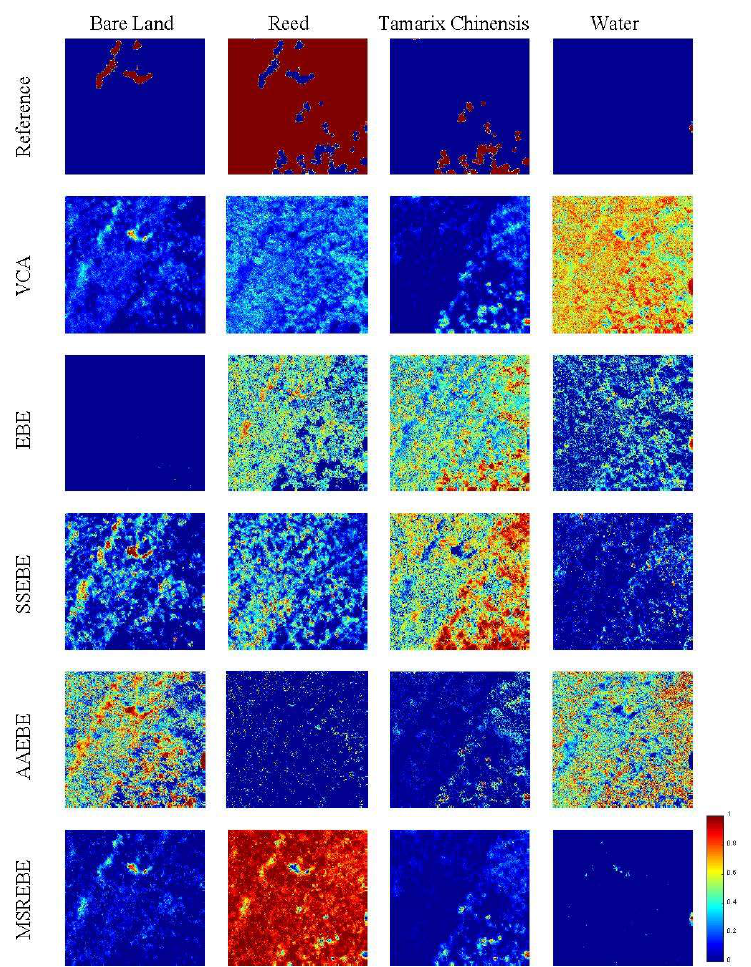
Figure 10. The abundance estimation results of Yellow River